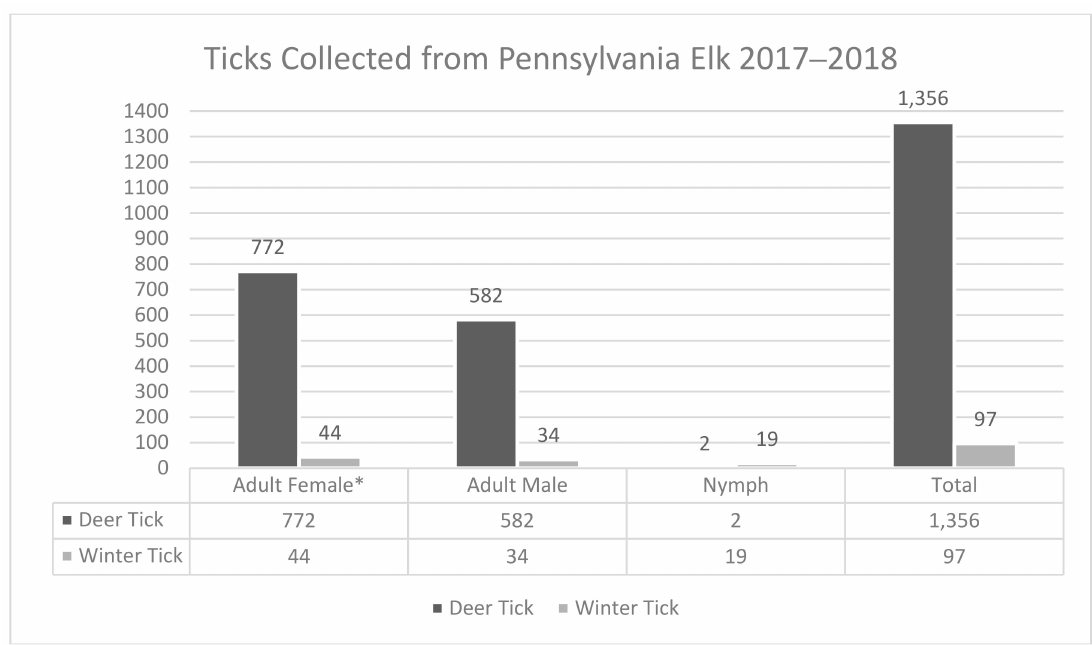
Figure 1. Total number of ticks collected from Pennsylvania elk during the 2017 and 2018 elk hunt. Data is separated by species, sex, and life stage. * Significance of less than 0.05 to adult males. Table 2. Break-down of tick collection data separated by species and year. Average tick load, range per elk, total tick collections, tick life stage and sex are outlined for species and year. Overall, 1453 ticks were collected from a total of 190 elk during the 2017 (99 elk; 931 ticks) and 2018 (91 elk; 522 ticks) Pennsylvania elk hunt. The average tick load for both years combined was 7.7 with a range of 0–42 ticks per elk. The average winter tick load on all elk was 0.5 with a range of 0–9 winter ticks per elk. Deer Tick Winter Tick Total